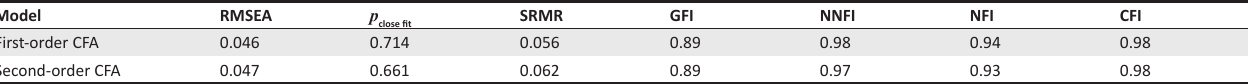
TABLE 2: Goodness-of-fit indices obtained for the cultural intelligence scale measurement and structural models. Model